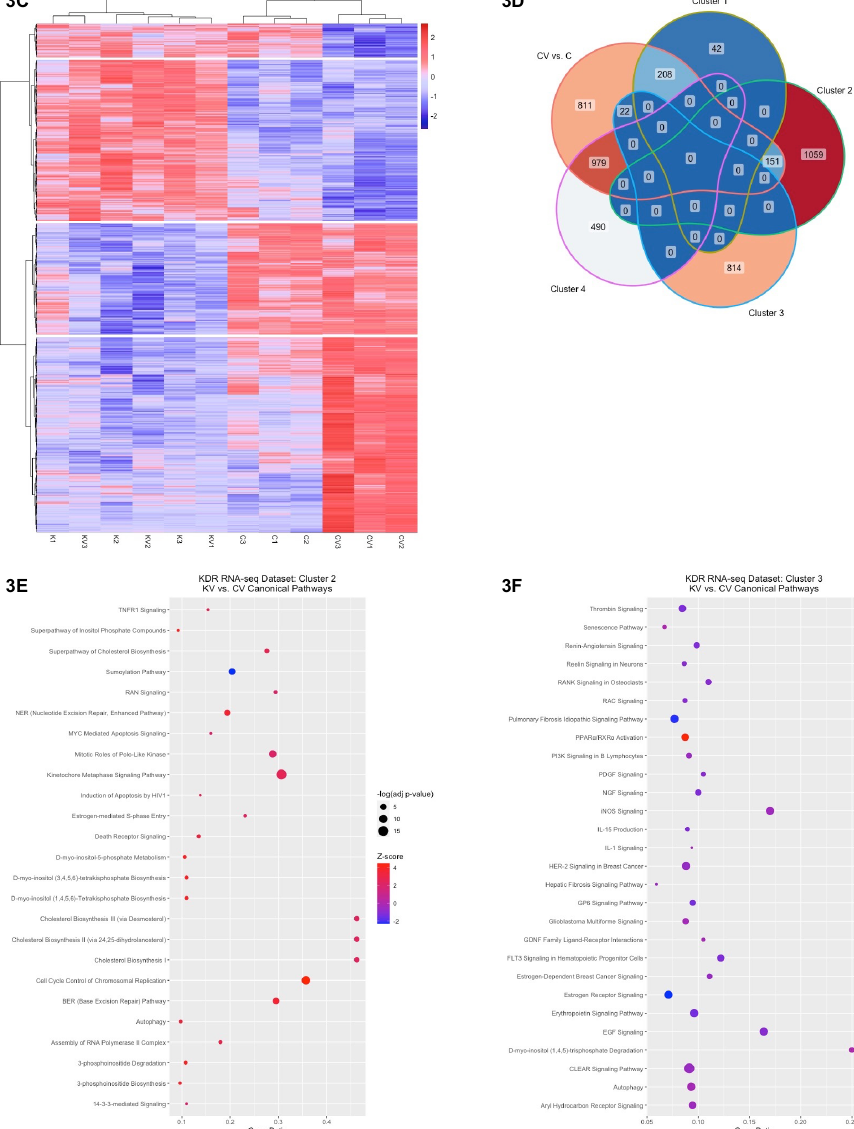
Figure 3. VEGFR2-mediated gene regulation and pathway enrichment in HRMECs. ( A ) Visualization of the VEGF-induced VEGFR2-mediated genes (VEGF-treated KDR siRNA-transfected HRMECs (KV) group compared to the VEGF-treated control siRNA-transfected HRMECs (CV) group) by volcano plot from the KDR RNA-seq dataset (black dashed line represents significance threshold value of − log(adjusted p -value) = 1.30; the color gradient visually depicts the fold of gene upregulation (red) and downregulation (blue) in the KV group compared to the CV group); ( B ) visualization of the common genes between the VEGF-mediated genes (i.e., CV vs. C) and the VEGF-induced VEGFR2-mediated genes (KV vs. CV) by a Venn diagram (color gradient visually depicts the relatively higher number of gene counts (red) or relatively lower number of gene counts (blue); ( C ) hierarchical clustering of the VEGF-induced VEGFR2-mediated genes identified four different clusters of gene expression patterns (row dendrogram, color gradient represents higher (red) or lower (blue) Z-score values of the RLog transformed read counts for each biologic sample ( n = 12, column dendrogram) relative to each gene); ( D ) Venn diagram depicting the overlap of VEGF-mediated genes (CV vs. C) with the VEGF-induced VEGFR2 (KV vs. CV) hierarchical clusters; bubble plots depicting the significantly enriched and significantly activated or inactivated pathways associated with the VEGF- induced VEGFR2-mediated genes from ( E ) cluster 2 or ( F ) cluster 3 (size of bubble directly